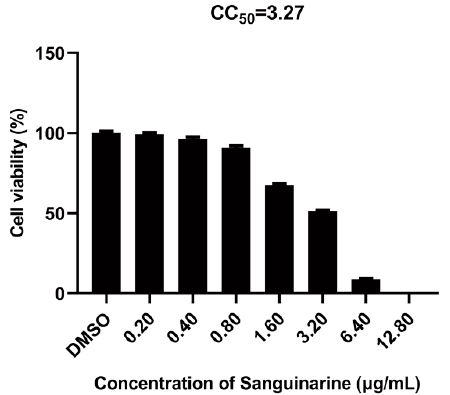
Figure 1. Cytotoxicity of sanguinarine on MARC-145 cells. MARC-145 cells were incubated with sanguinarine at different concentrations (0.20, 0.40, 0.80, 1.60, 3.20, 6.40, and 12.80 µ g/mL) for 36 h; then, the cell viability was estimated using CellTiter-Glo Luminescent Cell Viability Assay. Data are expressed as the means from three independent